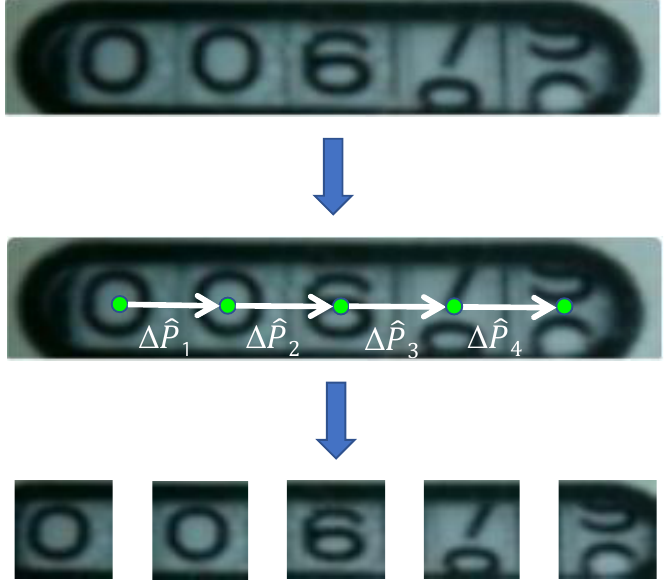
Figure 6. Keypoint localization method with spatial layout guidance. The five green points are on the same line and are